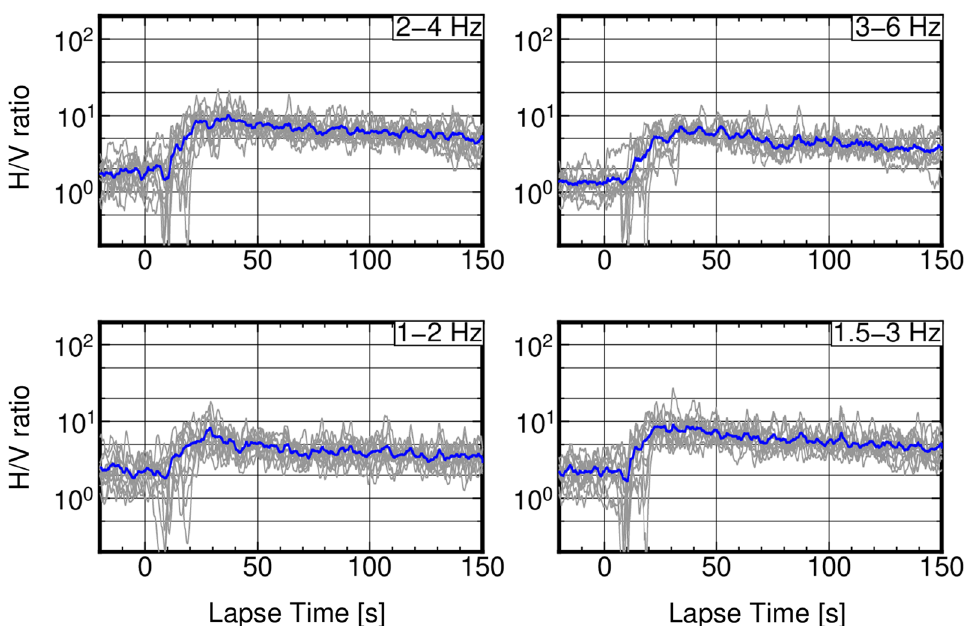
Fig. 4 H/V ratio envelopes at M.KMB06. The gray lines are H/V ratio envelopes for each earthquake. Signal-to-noise ratios for coda parts of each envelopes are larger than 5. The blue envelopes are stacked H/V ratio envelopes for each frequency band